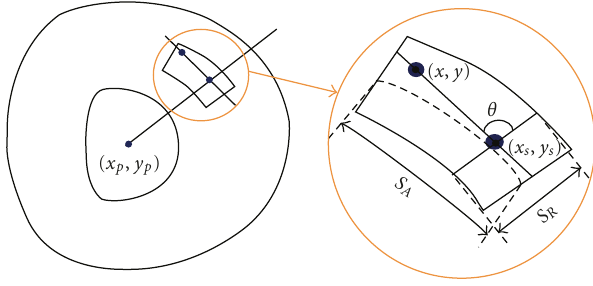
Figure 4: The description of S R , S A , θ , ( x , y ), and ( x p , y p ). the tolerance of segmentation error of the pupil boundary region and the limbic region (i.e., adding 2 more regions in the radius direction), we use x = 10 in our